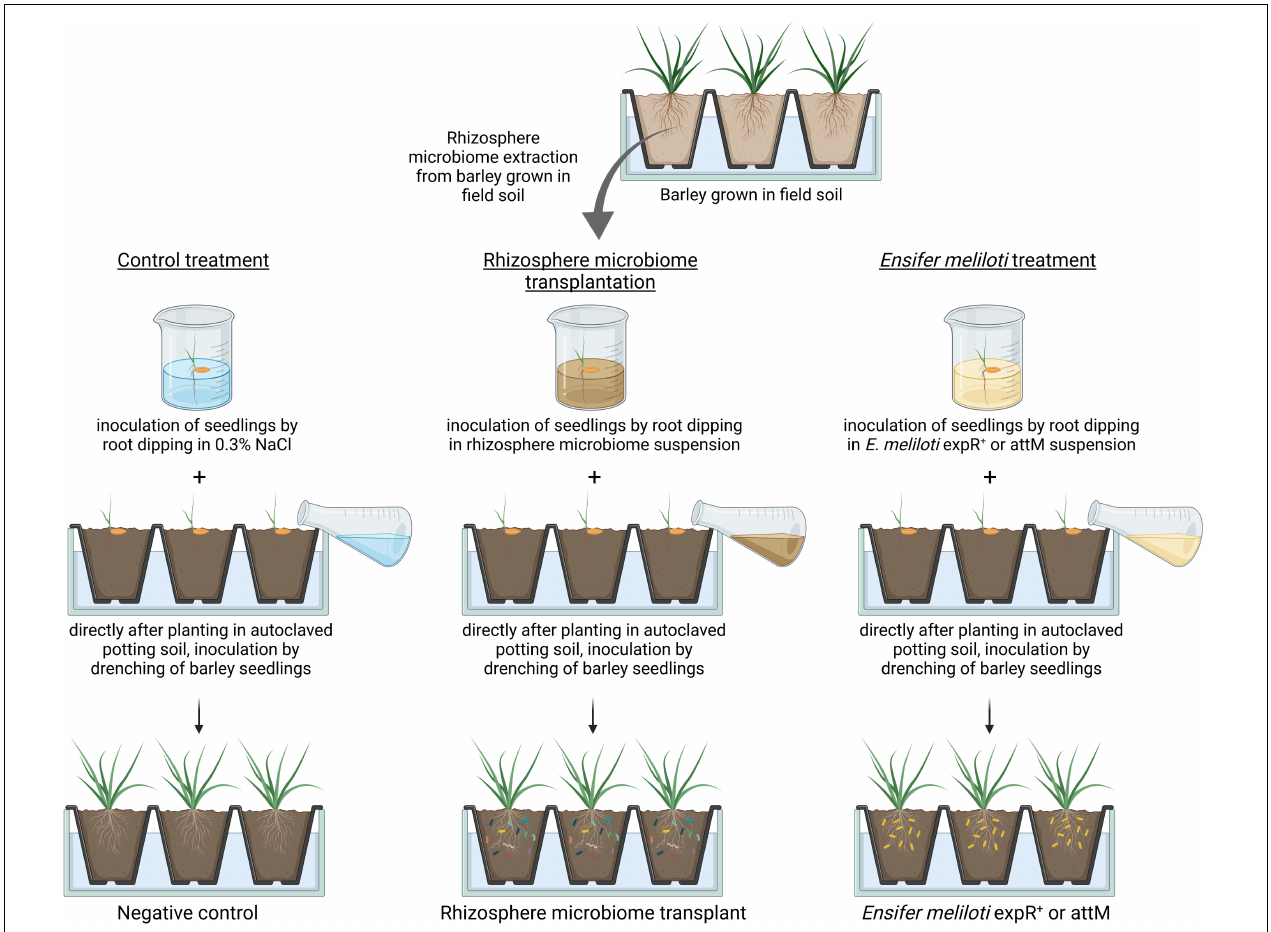
FIGURE 1 | Experimental design for rhizosphere microbiome transplantation. The barley cultivar “Golden Promise” was grown in field soil under greenhouse conditions. At the three-leaf stage (BBCH13), the rhizosphere microbiome was harvested and a rhizosphere microbiome suspension was prepared. Barley seedlings were dipped into the rhizosphere microbiome suspension, planted into autoclaved potting soil, and then additionally drenched with the rhizosphere microbiome suspension. Dipping of seedlings prior to drenching was as well performed for control plants with saline (0.3% NaCl) and for plants treated with either of the two Ensifer meliloti strains expR + and attM. The figure was created with